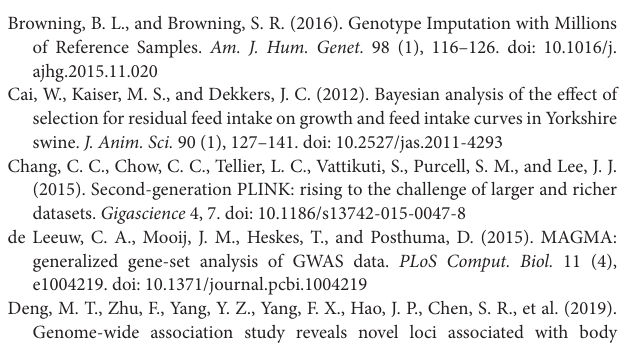
TABLE S1 | Variance analysis for sex and batch effects TABLE S2 | Functional annotation of candidate genes FIGURE S1 | Distribution of SNPs in 1Mb windows along the genome FIGURE S2 | PCA analysis of Pekin